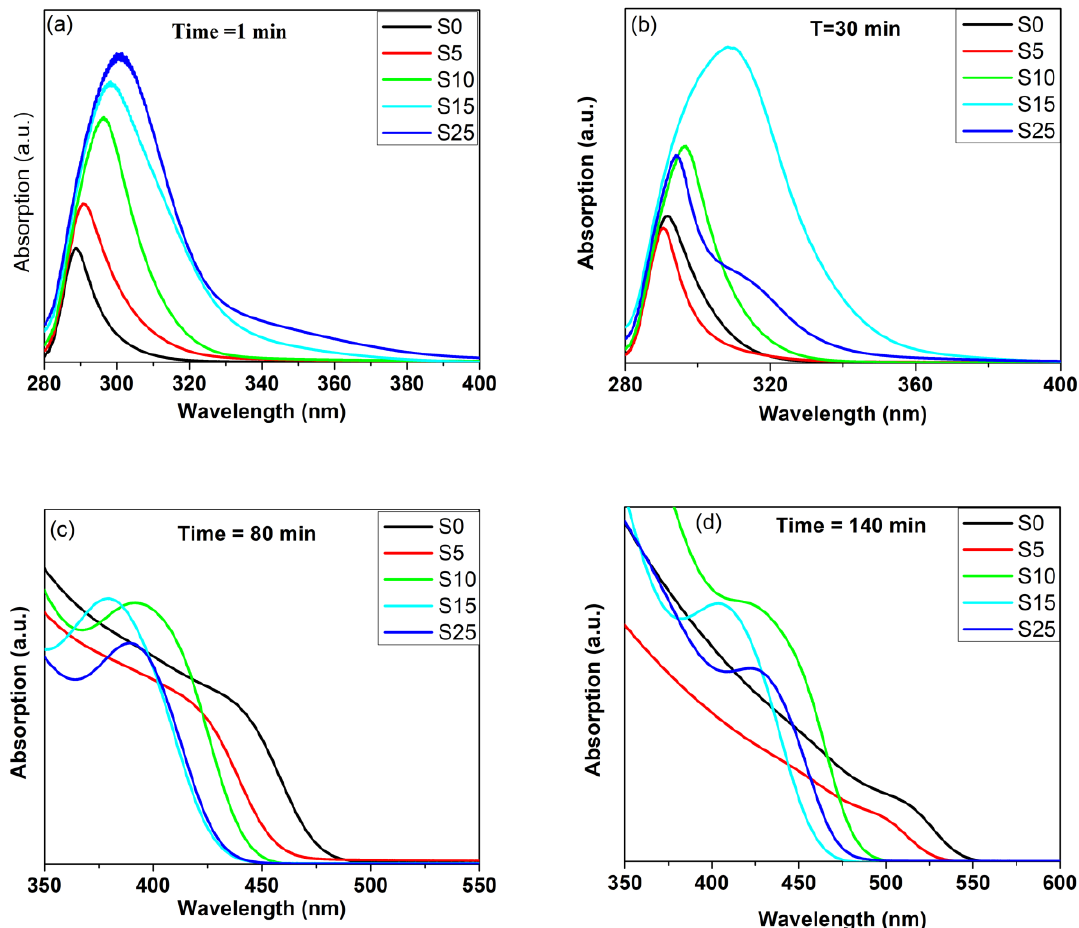
Figure 8. Optical absorption spectra of aliquots of binary CdSe and ternary alloy with different percentages of S: ( a ) After one minute of reaction, ( b ) after 30 min, ( c ) after 80 min, and ( d ) after 140 min.